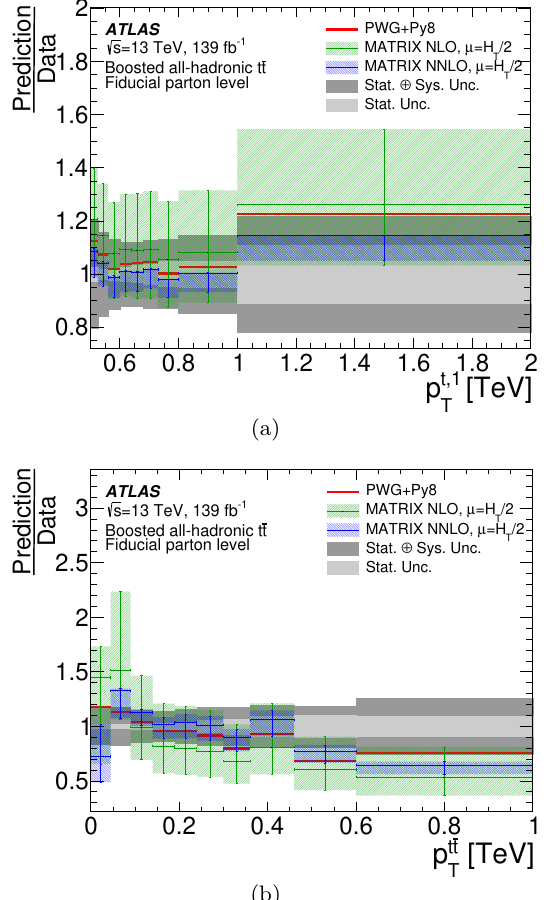
Figure 33 . Comparison of the NLO, NNLO, and Powheg+Pythia 8 calculations with measured parton-level fiducial phase-space absolute differential cross-sections for (a) the p T of the leading top quark, and (b) the p T of the t ¯ t system, p t ¯ t . The dark and light grey bands indicate the total T uncertainty and the statistical uncertainty, respectively, of the data in each bin. The fixed-order calculation bands correspond to the scale uncertainty. The Powheg+Pythia 8 calculation is not normalized to the NNLO total inclusive